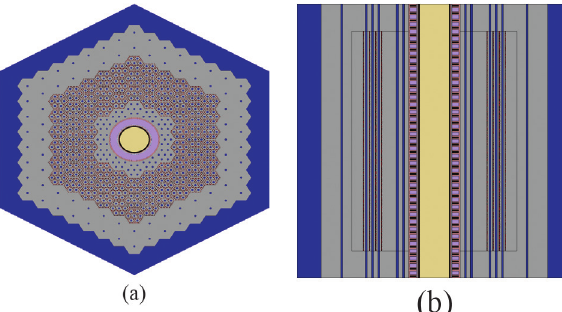
Figure 2. Detailed 3D model of the fusion-fission hybrid reactor facility: a) – cross section; b) – longitudinal section.